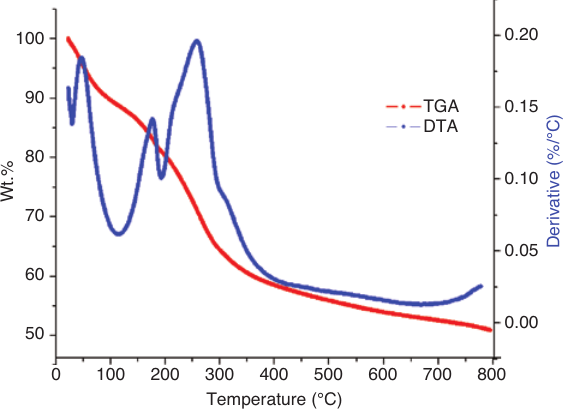
Figure 5: TGA/DTA thermogram of D. erecta synthesized